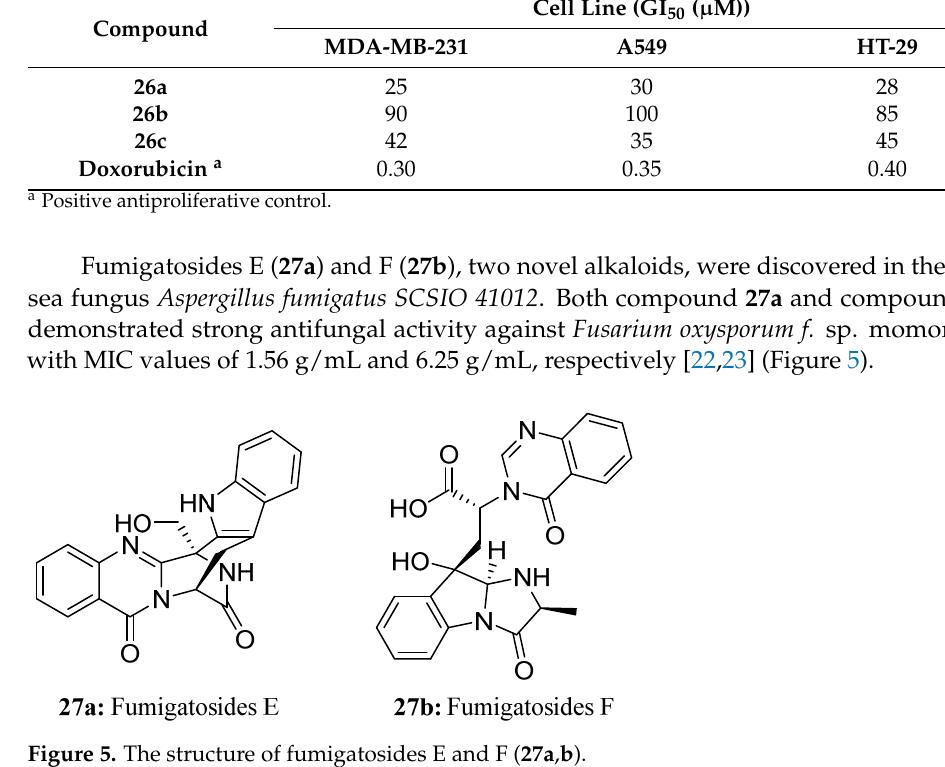
Table 1. Cancer cell line inhibition by hyrtioerectines D-F ( 26a - 26c ). Compound